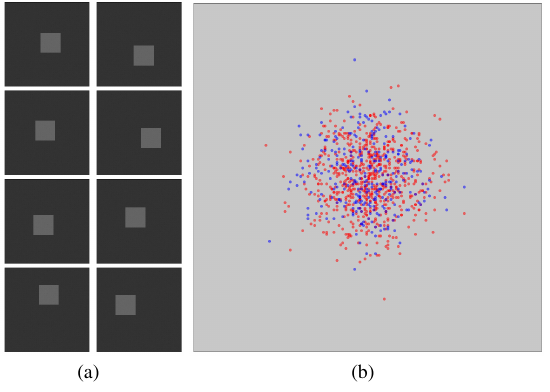
Figure 2. (a) Examples from the training dataset. (b) Distributions of the square center positions in the training (red) and validation (blue) dataset.